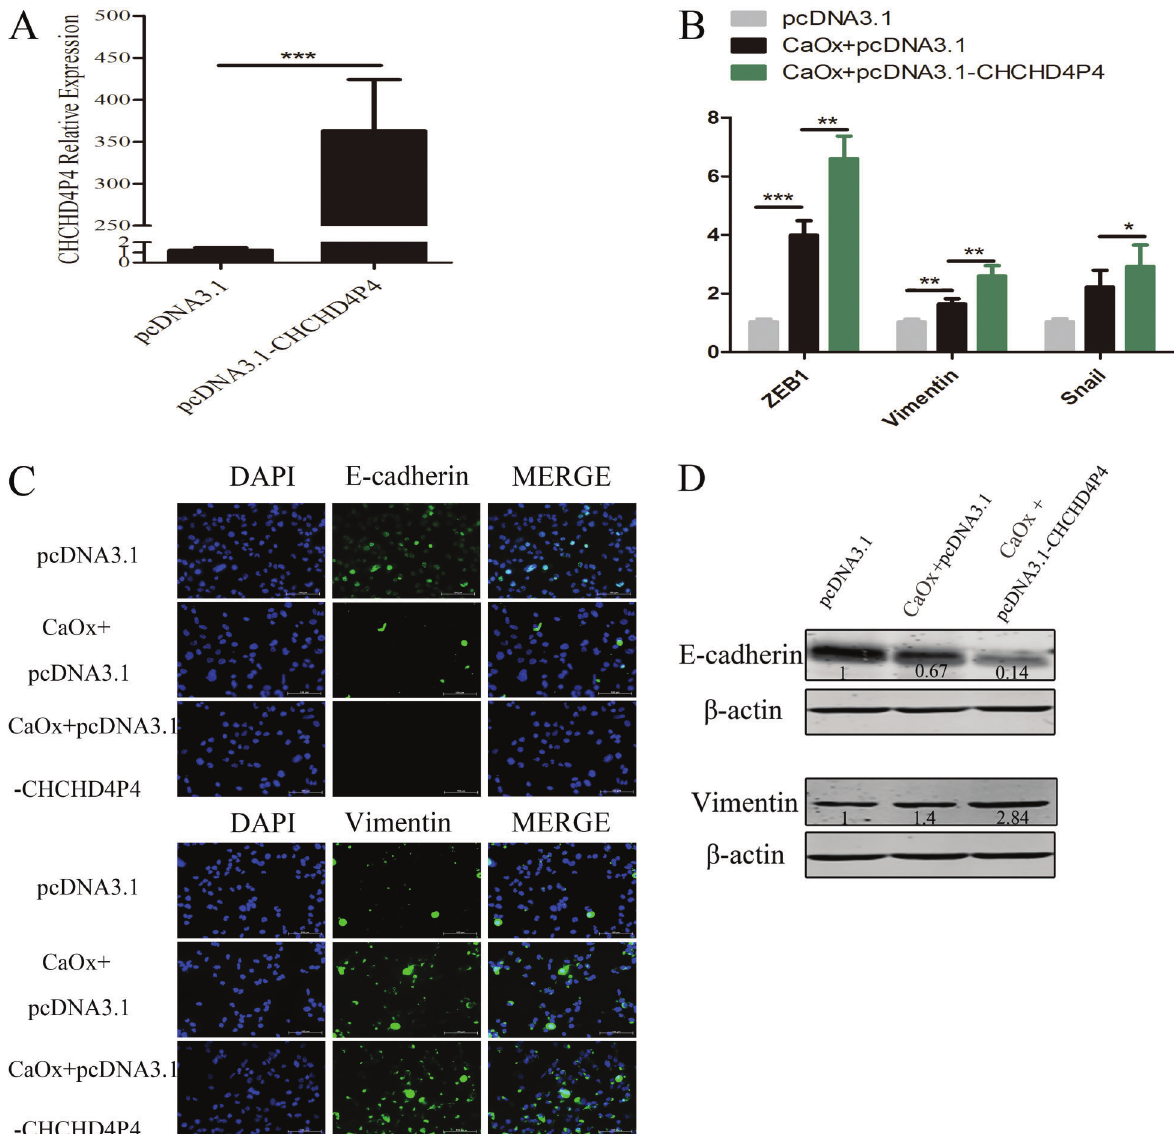
Figure 4. CHCHD4P4 overexpression. HK-2 cells were incubated with pcDNA3.1 encoding CHCHD4P4 cDNA ( A ) for 6 h for a stable transfection. HK-2 cells were treated with pcDNA3.1 or pcDNA3.1-CHCHD4P4 combined with calcium oxalate monohydrate (200 m g/mL) for 24 h. mRNA levels of the epithelial-mesenchymal transition (EMT) markers in the stable HK-2 cell clones ( B ). Protein levels ( D ) and immuno fl uorescence microscopic analysis ( C ) of the EMT markers in the indicated HK-2 cell clones. Scale bars = 100 m m. Data are reported a means ± SD. *P o 0.05, **P o 0.01, ***P o 0.001 (Student ’ s t